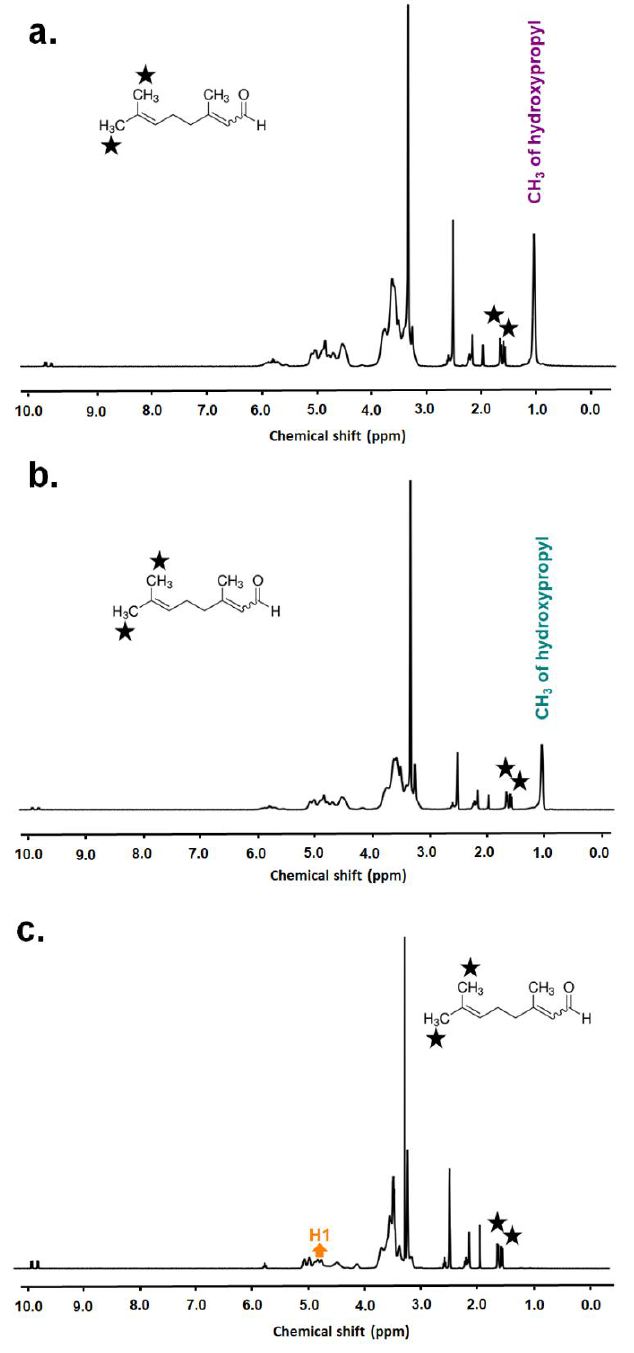
Figure 5. 1 H NMR spectra of ( a ) citral/HP β CD-IC-NF, ( b ) citral/HP γ CD-IC-NF, and ( c ) citral/M β CD-IC-NF Figure 5 . 1 H NMR spectra of ( a ) citral/HPβCD-IC-NF, ( b ) citral/HPγCD-IC-NF, and ( c ) citral/MβCD- dissolved in IC-NF dissolved in d6-DMSO.